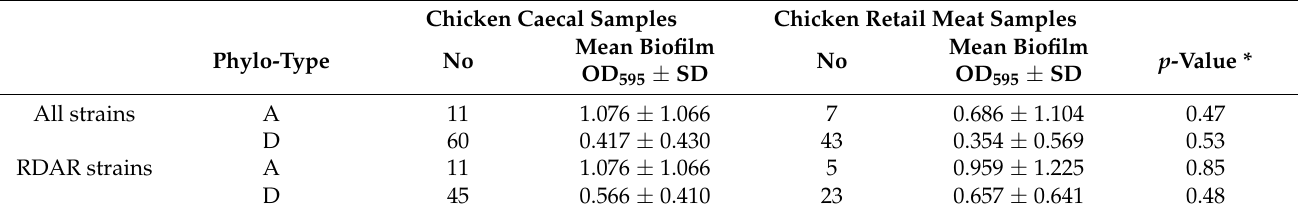
Table 6. Comparison of biofilm production by ESCR E. coli strains from chicken caecal and retail meat samples, as indicated by OD 595 in the crystal violet biofilm assay, within phylotypes A and D of all strains, and of strains with the morphotype RDAR.